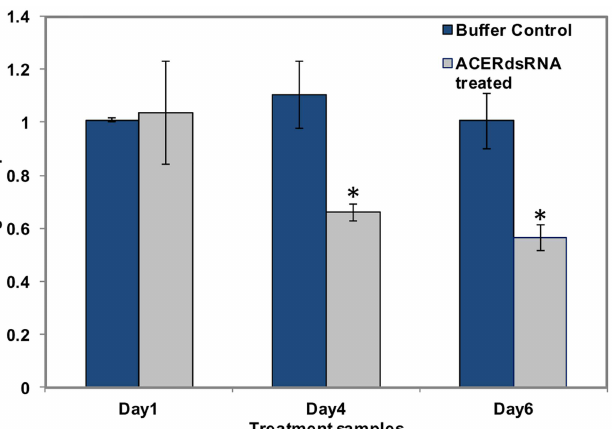
Fig 1. Results of real-time qPCR analysis of a neurotransmission gene target. The qPCR expressionof target whitefly genes involvedin neurotransmission, post-RNAi knock down. (A) The bar graphs show the comparisons in fold-changeof expressionof the Acetylcholine receptor subunitalpha ( AChR α )when whiteflieswere treated with 30 μ g/mlof AChR α dsRNA (gray bars), and the buffer treated control (blue bars) at day one, four, and six (x-axis). The “asterisk” indicatesa significant p- value( < 0.05) ( t- test).